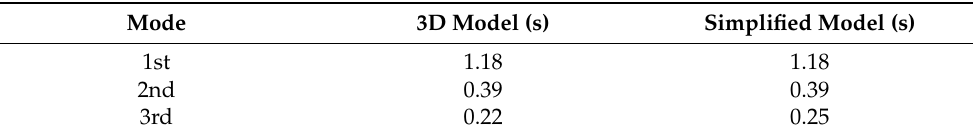
Table 5. Comparison of natural periods between 3D and simplified planar model ( y